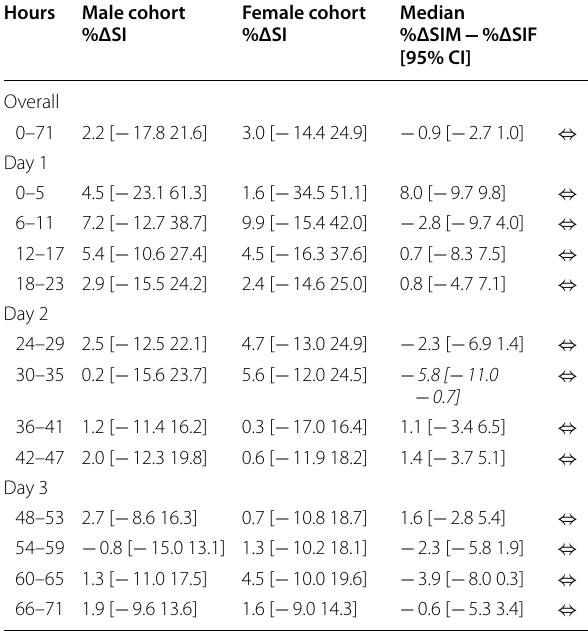
Table 3 Median [IQR] %ΔSI (%) levels comparison between male and female cohorts using 6-h